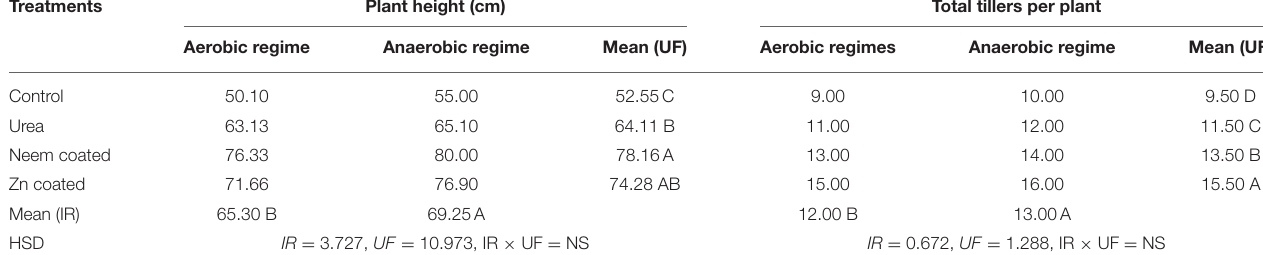
TABLE 2 | Impact of conventional urea, neem-coated and zinc-coated urea on plant height, total number of tillers per plant, number of spikelets per panicle, and number of filled grains per panicle of rice plants grown in aerobic and anaerobic regimes. Treatments